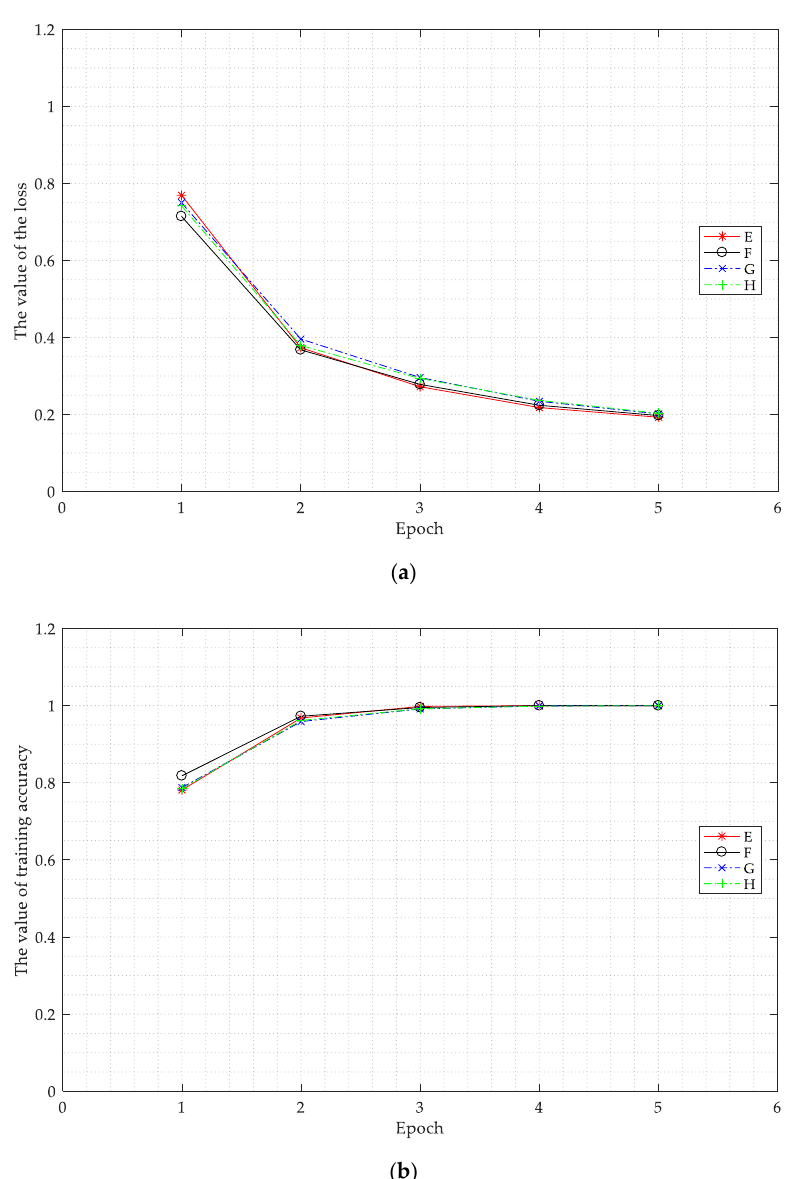
Figure 13. The value of the loss function ( a ) and the value of training accuracy of the training set ( b ) corresponding to the different sizes of convolution kernels as the epoch changed. Kernel sizes (3, 3), (5, 5), (7, 7), and (9, 9) are expressed as E, F, G, and H, respectively.